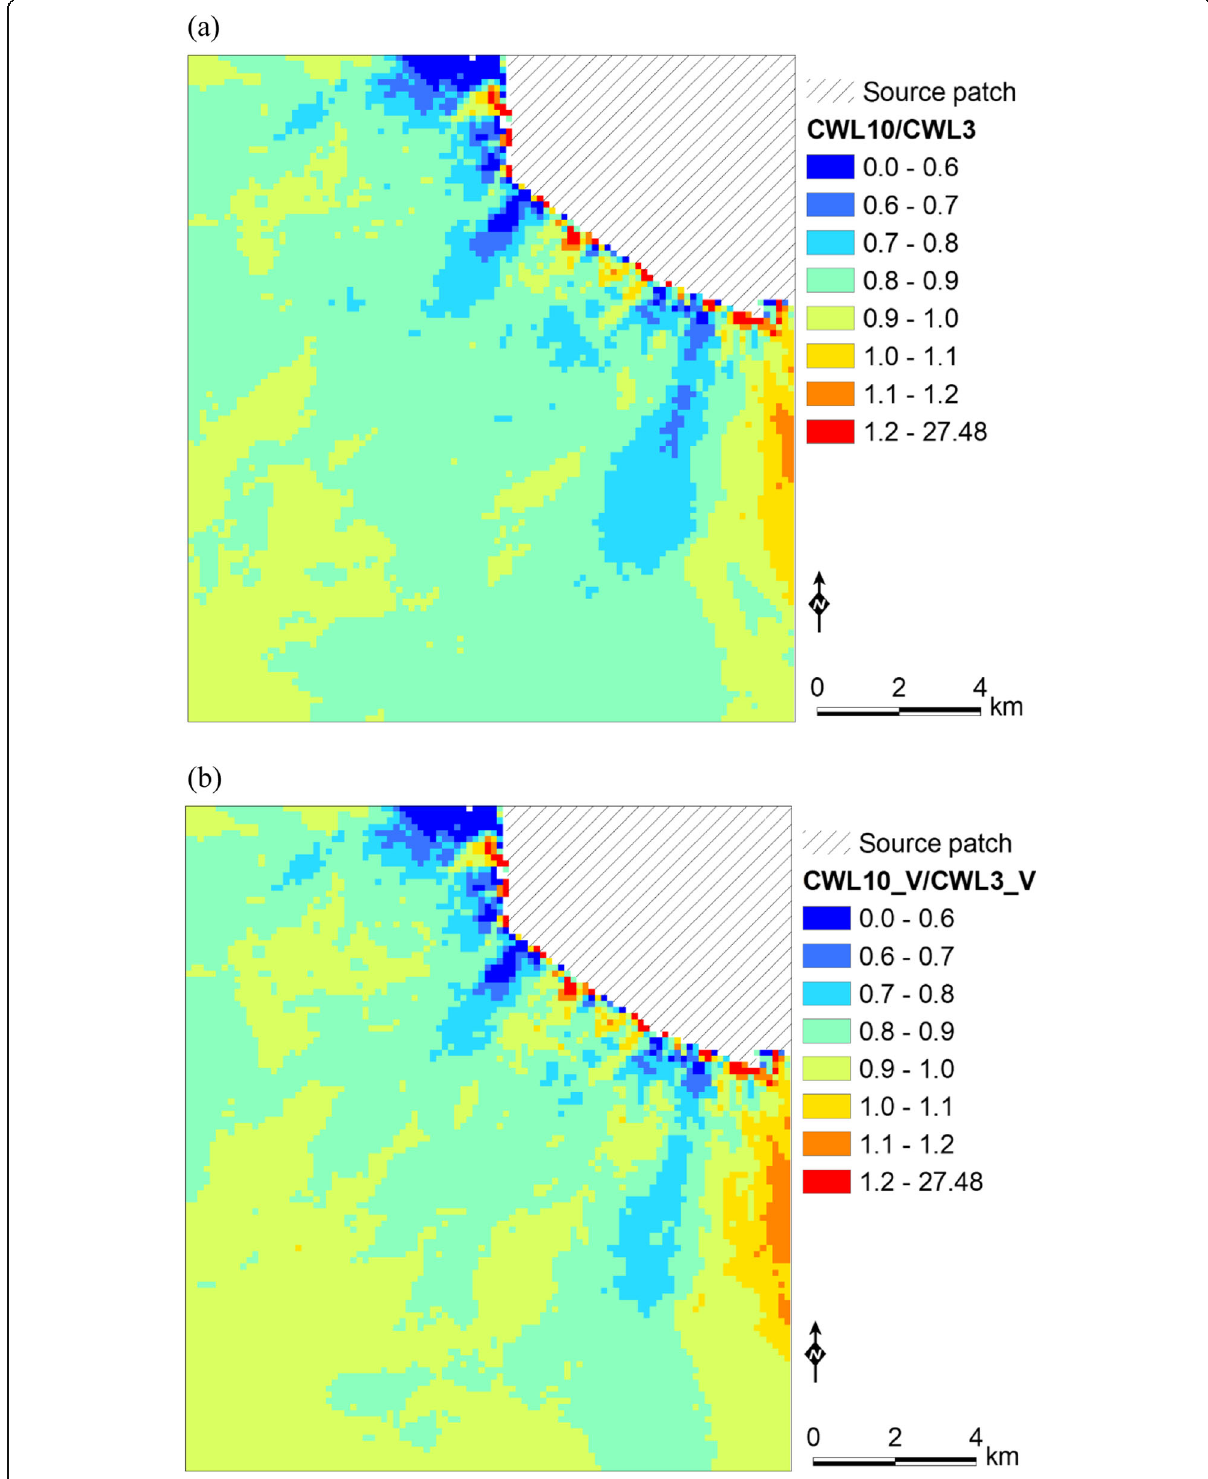
Fig. 9 Spatial distribution of 9203 sample values of a CWL10/CWL3 and b